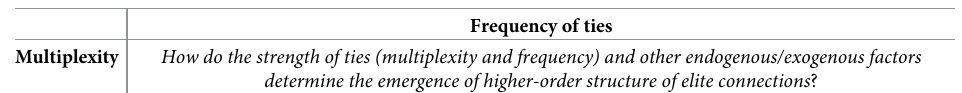
Table 4. New question on elite cohesion.